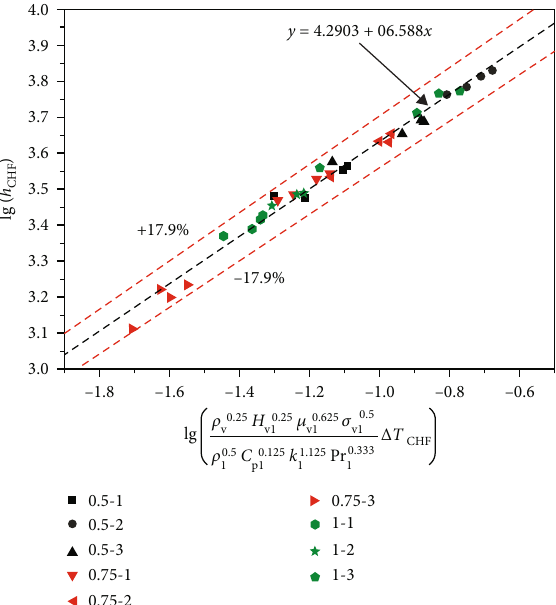
Figure 22: Correlation on h